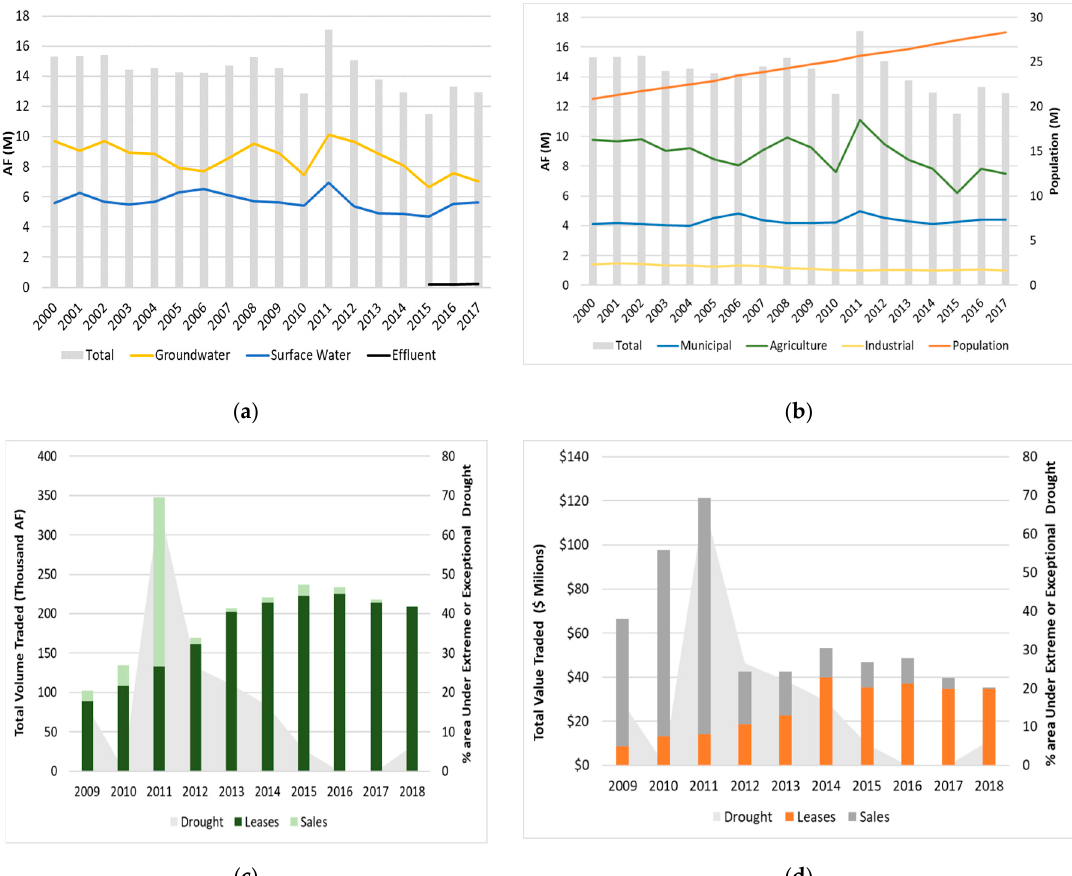
Figure 4. ( a ) Water supply by source, ( b ) water demand by sector, ( c ) total volume traded, and ( d ) total value traded in Texas. Source: Authors’ calculations, Texas Department of Water Resources, and WestWater Research. Drought data are from the US drought monitor [31]. All prices are in real 2009$ using the CPI—All Urban Consumers Average from the BLS.